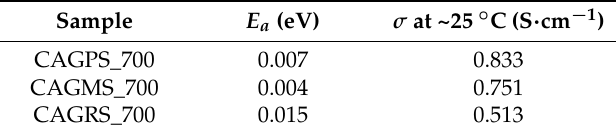
Table 3. Electrical properties of carbon aerogels pyrolysed at 700 ◦